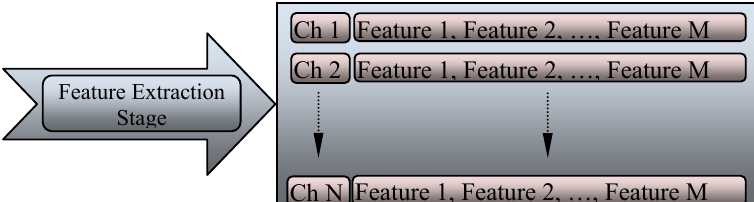
Feature 1, Feature 2, …, Feature M Ch